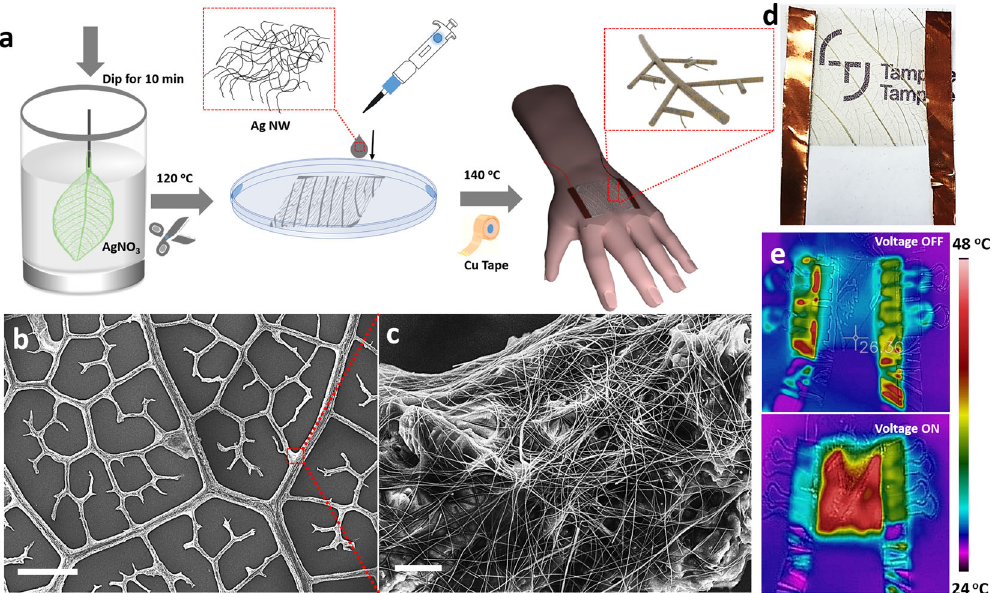
Fig. 1 Fabrication and general morphology. a Schematic of fabrication of a bioinspired thermotherapy patch. b , c SEM images of Ag nanowire-coated skeleton. d The fi nal assembled bioinspired thermotherapy patch. e The infrared thermal camera images of the bioinspired thermotherapy patch. The scale bars in b and c are 500 and 10 μ m,